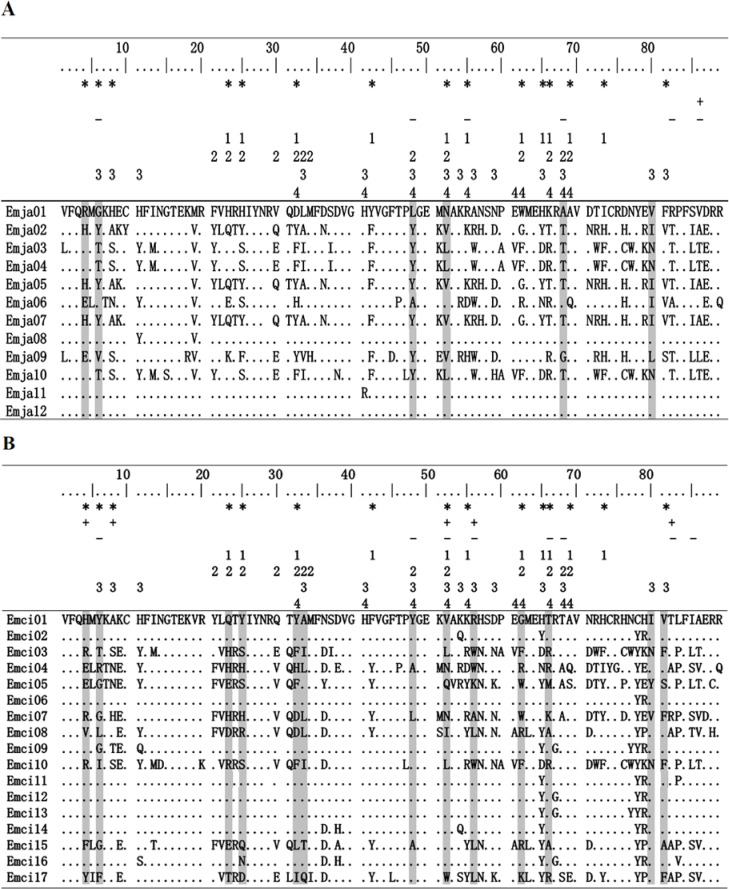
Alignment of MHCIIB exon 2 amino acid sequences.Emberiza jankowskii and Emberiza cioides were the two species selected for this analysis. Periods and dots indicate identity with the Emja01 or Emci01 sequence. Emja04 = Emci03, Emja05 = Emja07 = Emci11, Emja01 = Emja12. Emja represents Emberiza jankowskii, Emci represents Emberiza cioides. * represents putative peptide-binding sites based on Tong et al. (2006); + represents sites identified by SLAC in this study; - represents sites identified by FEL in this study; 1represents Luscinia svecica (FJ529861; Anmarkrud et al., 2010); 2 represents Ficedula albicollis (HQ678311; Zagalska-Neubauer et al., 2010); 3 represents Philesturnus carunculatus (KF225737; Sutton et al., 2013); 4 represents Passer domesticus (Pado-DAB*301; Borg et al., 2011). Sites identified by CODEML as being under positive selection by model M8 are shaded gray.